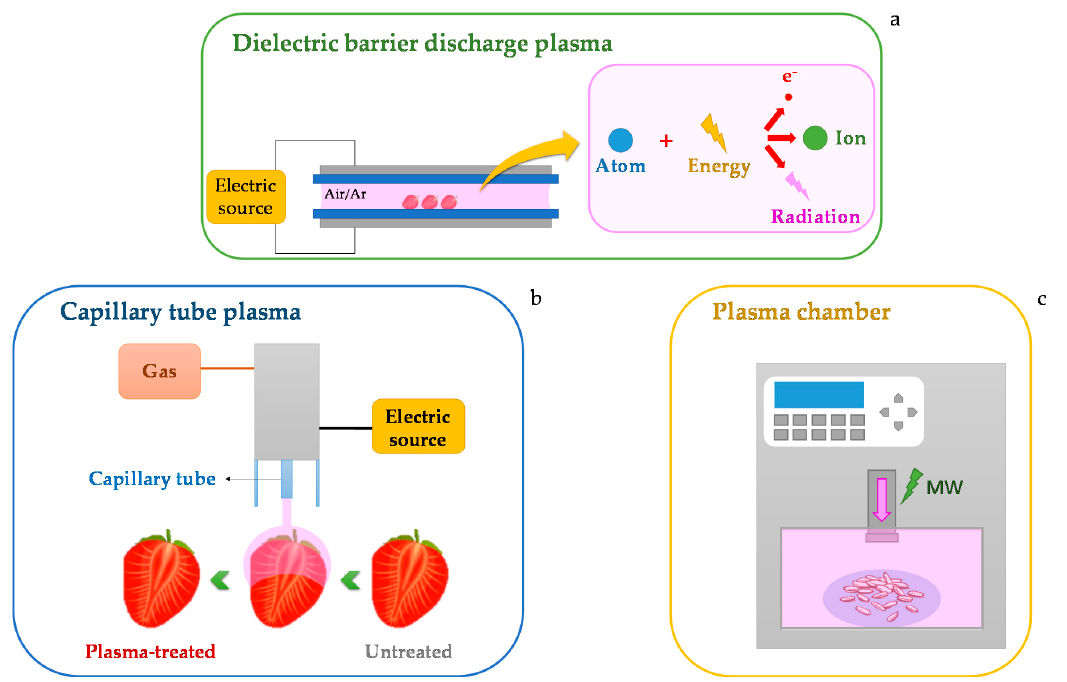
Figure 1. Schematic representation of the plasma equipment: ( a ) Dielectric barrier discharge; ( b ) Capillary tube plasma; ( c ) Plasma chamber. MW: microwave.